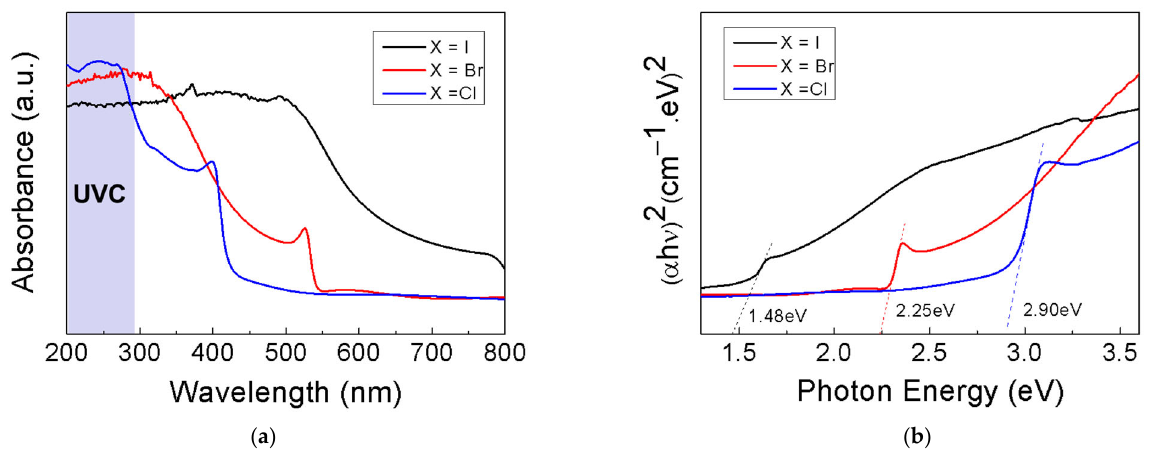
Figure 4. Light absorption and bandgap energy values of FAPbX 3 ‐ MAPbX 3 (X = I, Br, and Cl) thin films. ( a ) UV ‐ vis spectrum and ( b ) bandgap energy dependent on light absorption.